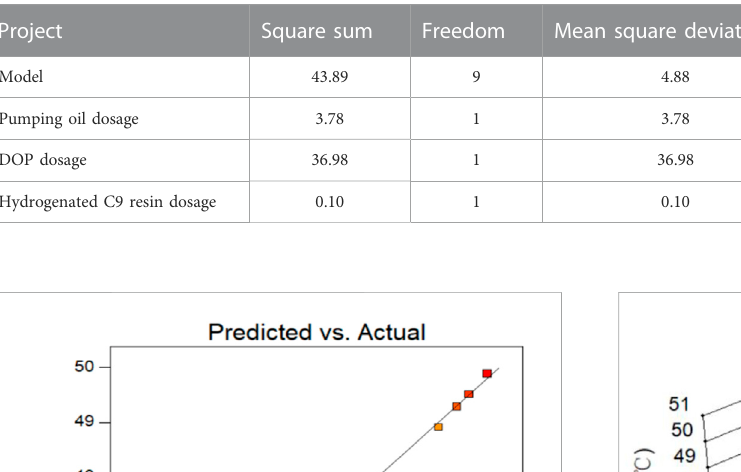
TABLE 10 Numerical analysis of the softening point.